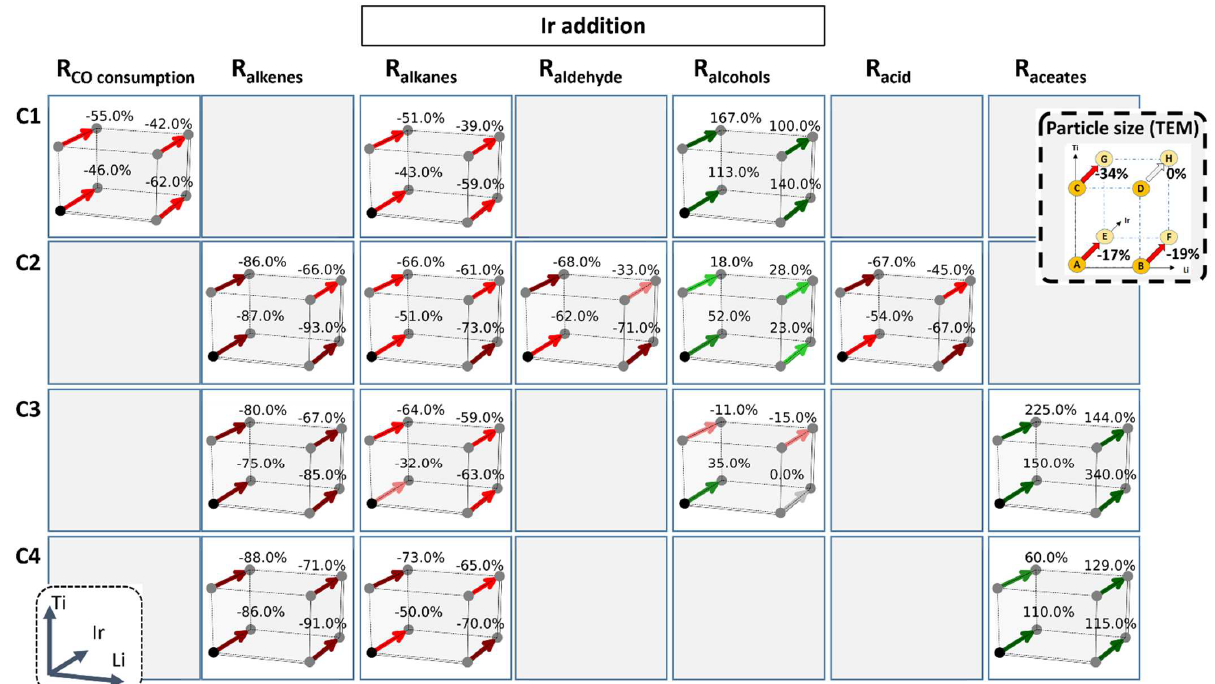
Figure 5. The studied effect of target promoter Ir in Exp 1 (T = 270 °C, P = 50 bar, total flow = 43 mL/min, H 2 :CO = 48:22 %V). Each column depicts a descriptor group. Going down in rows, descriptors are sorted based on the number of carbons from C1 to C4. An additional cube on the right shows the effect on average particle size. The arrows in each cube connect the reference catalyst (without Ir) to the treated catalyst (with Ir). The color of the arrows denotes the changes in the respective descriptor and the size effect. Green and red arrows show an increase and decrease, respectively, with their shade getting darker as the effect size increases. The green arrows in the rate of methanol, ethanol, and acetates cubes depict the positive effect size of Ir on those products.